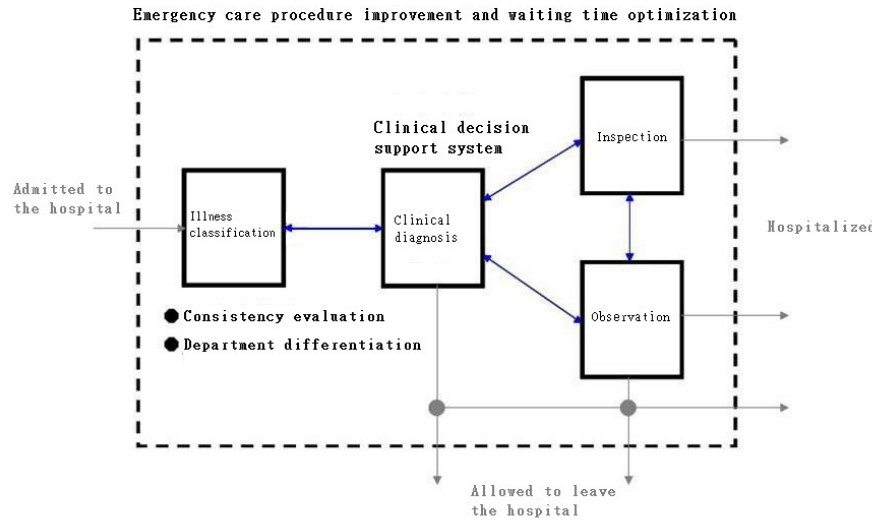
Figure 1. Process flow in the emergency care department.